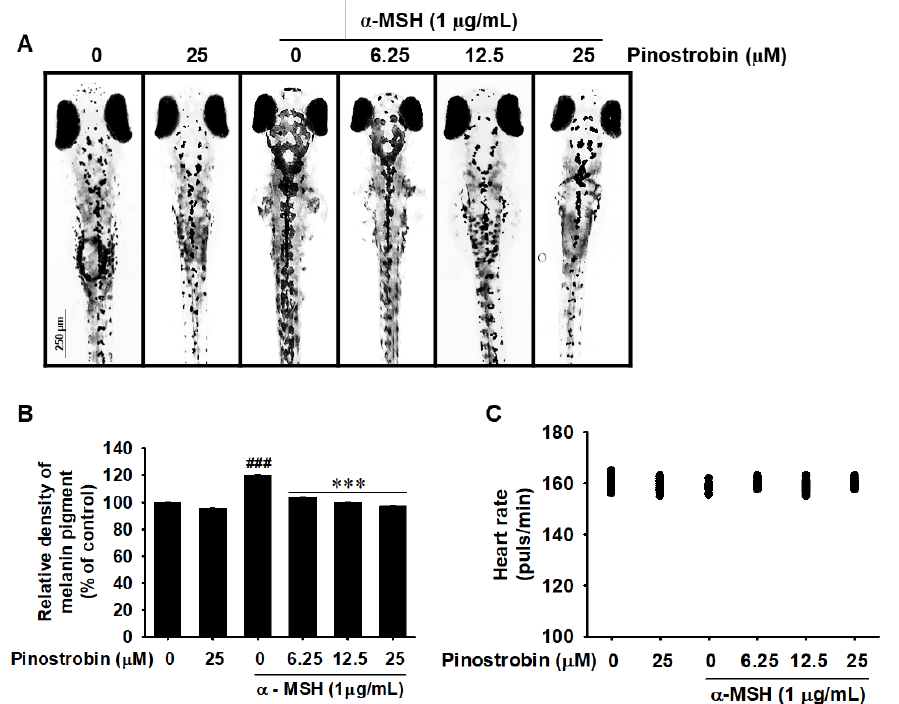
Figure 6. Pinostrobin inhibits melanin biosynthesis in zebrafish larvae. Zebrafish larvae at 2 dpf treated with phenylthiourea (PTU, 200 µM) and stimulated with α -melanocyte-stimulating hormone ( α -MSH, 1 µg/mL). ( A ) Microscopic evaluation of zebrafish larvae pigmentation (40×). ( B ) Relative melanin pigment density. Scale bar = 250 μm. ( C ) Average heart rate of zebrafish larvae ( n = 20). Data are reported as the mean ± SE. ### p < 0.001 vs. untreated zebrafish larvae; *** p < 0.001 vs. α -MSH-stimulated zebrafish larvae.